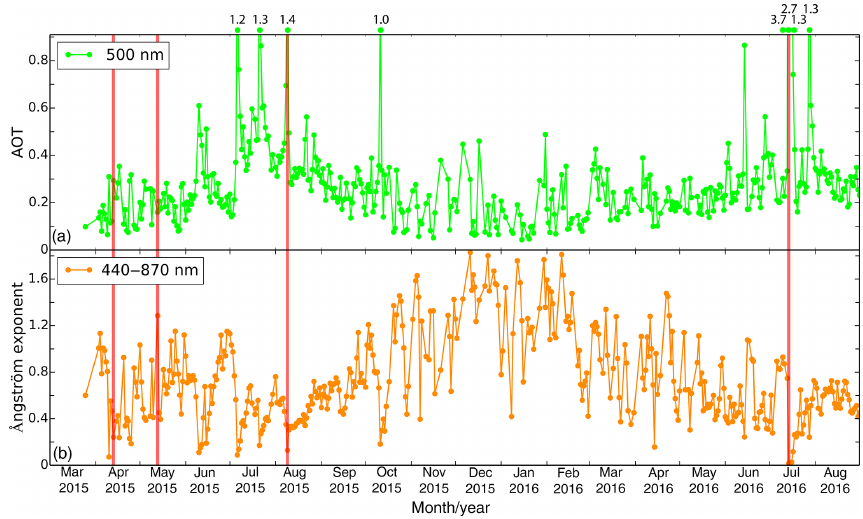
Figure 3. Daily means of the AOT (a) and Ångström exponent (b) measured in Dushanbe from March 2015 until August 2016 by sun photometer (AERONET Level 1.5, cloud-screened). The red lines indicate the days of the presented example cases.